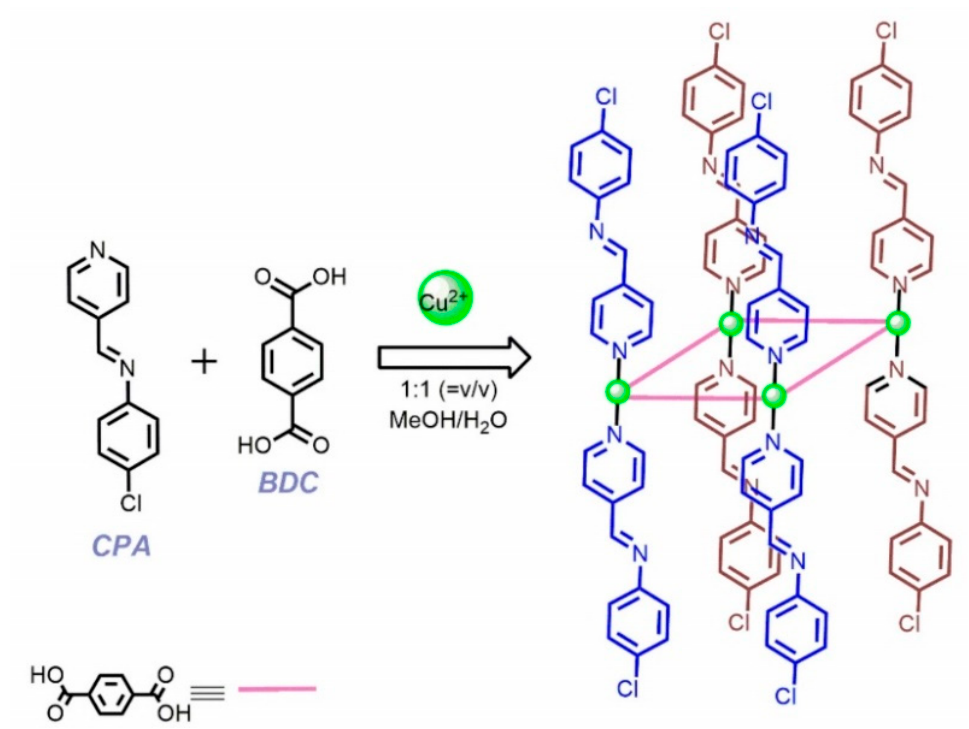
Figure 16. Schematic representation of synthesis of Cu-MOF [60].